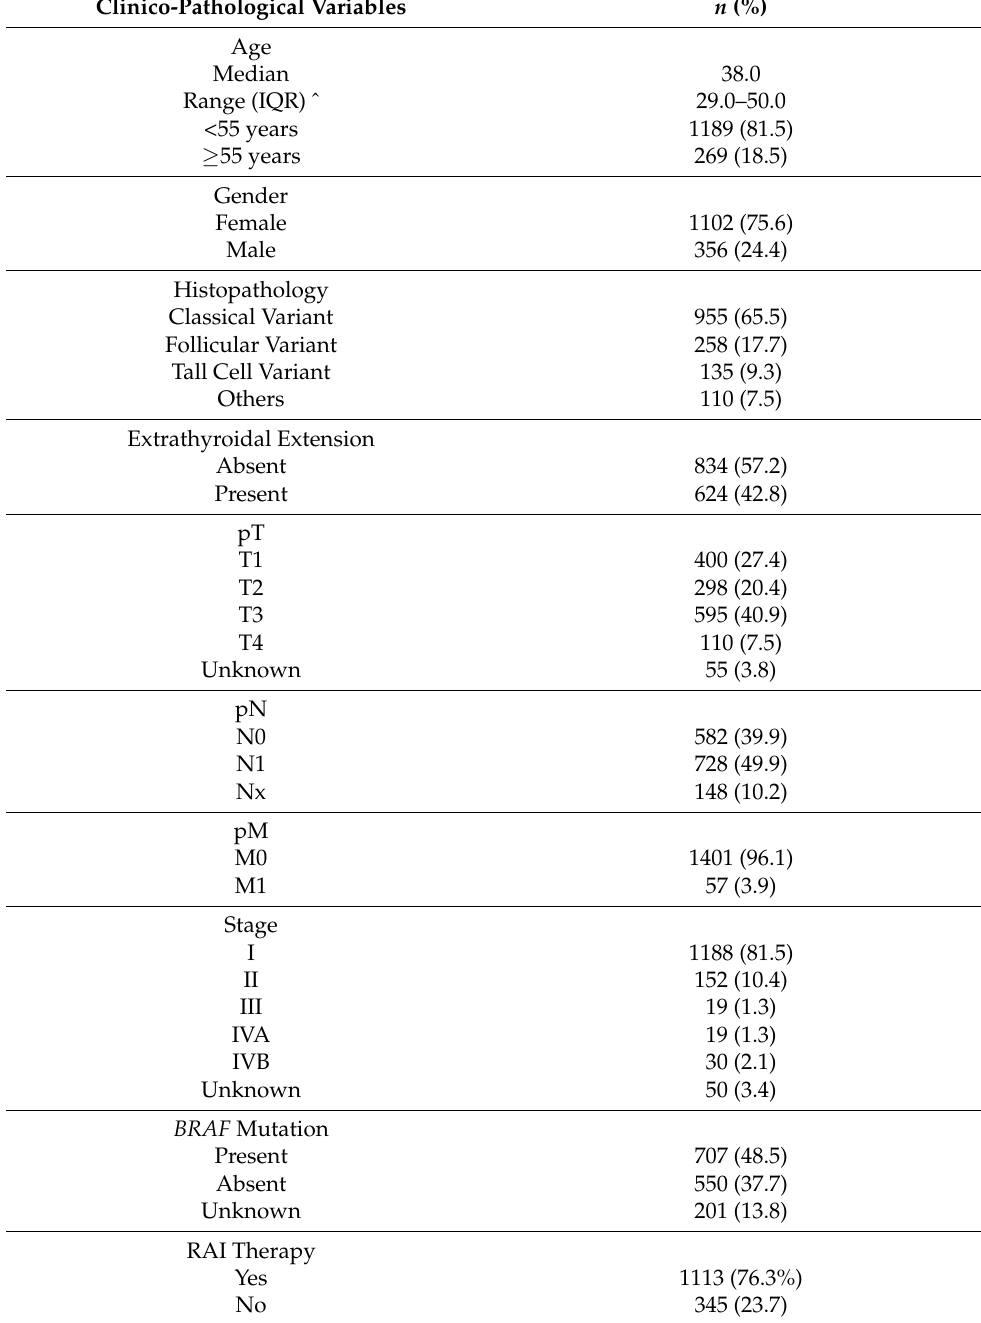
Table 3. Clinico-pathological variables for the patient cohort ( n =